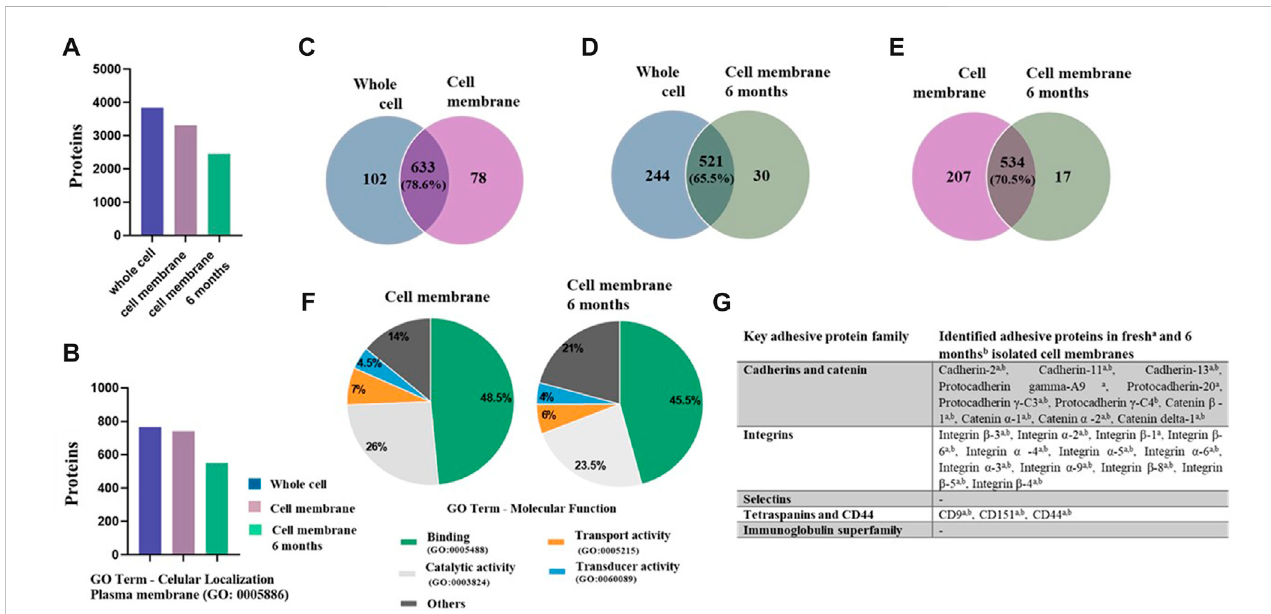
FIGURE 1 Qualitative data of proteomic analysis. Freshly isolated cell membranes, 6 months-stored isolated cell membranes, and whole U251 cells. (A) Total proteins quanti fi ed in freshly isolated cell MB, 6 months-stored isolated MB, and whole U251 cells. (B) Proteins were classi fi ed according to GO information. (C – E) Venndiagramsdisplaypro fi lesofcellmembraneproteincompositionbyoverlappingeachcondition. (F) Cellmembraneproteinswerefurtherclassi fi ed accordingtotheirmolecularfunctioninfreshlyand6 months-storedisolatedcellmembranesamples. (G) Keycancercelladhesionproteinsidenti fi edin freshly and 6 months-stored isolated cell membranes